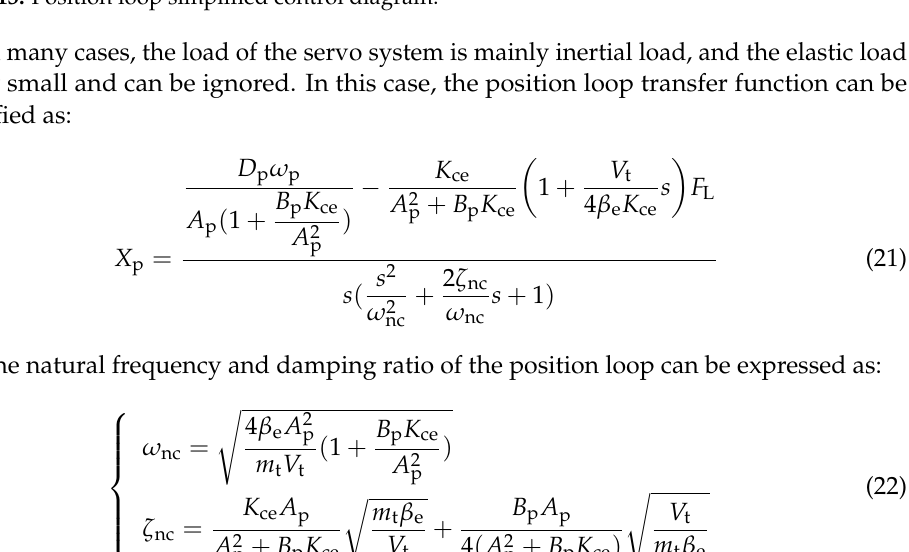
11 of 21 Table 2. Speed loop simulation model parameters. Parameter